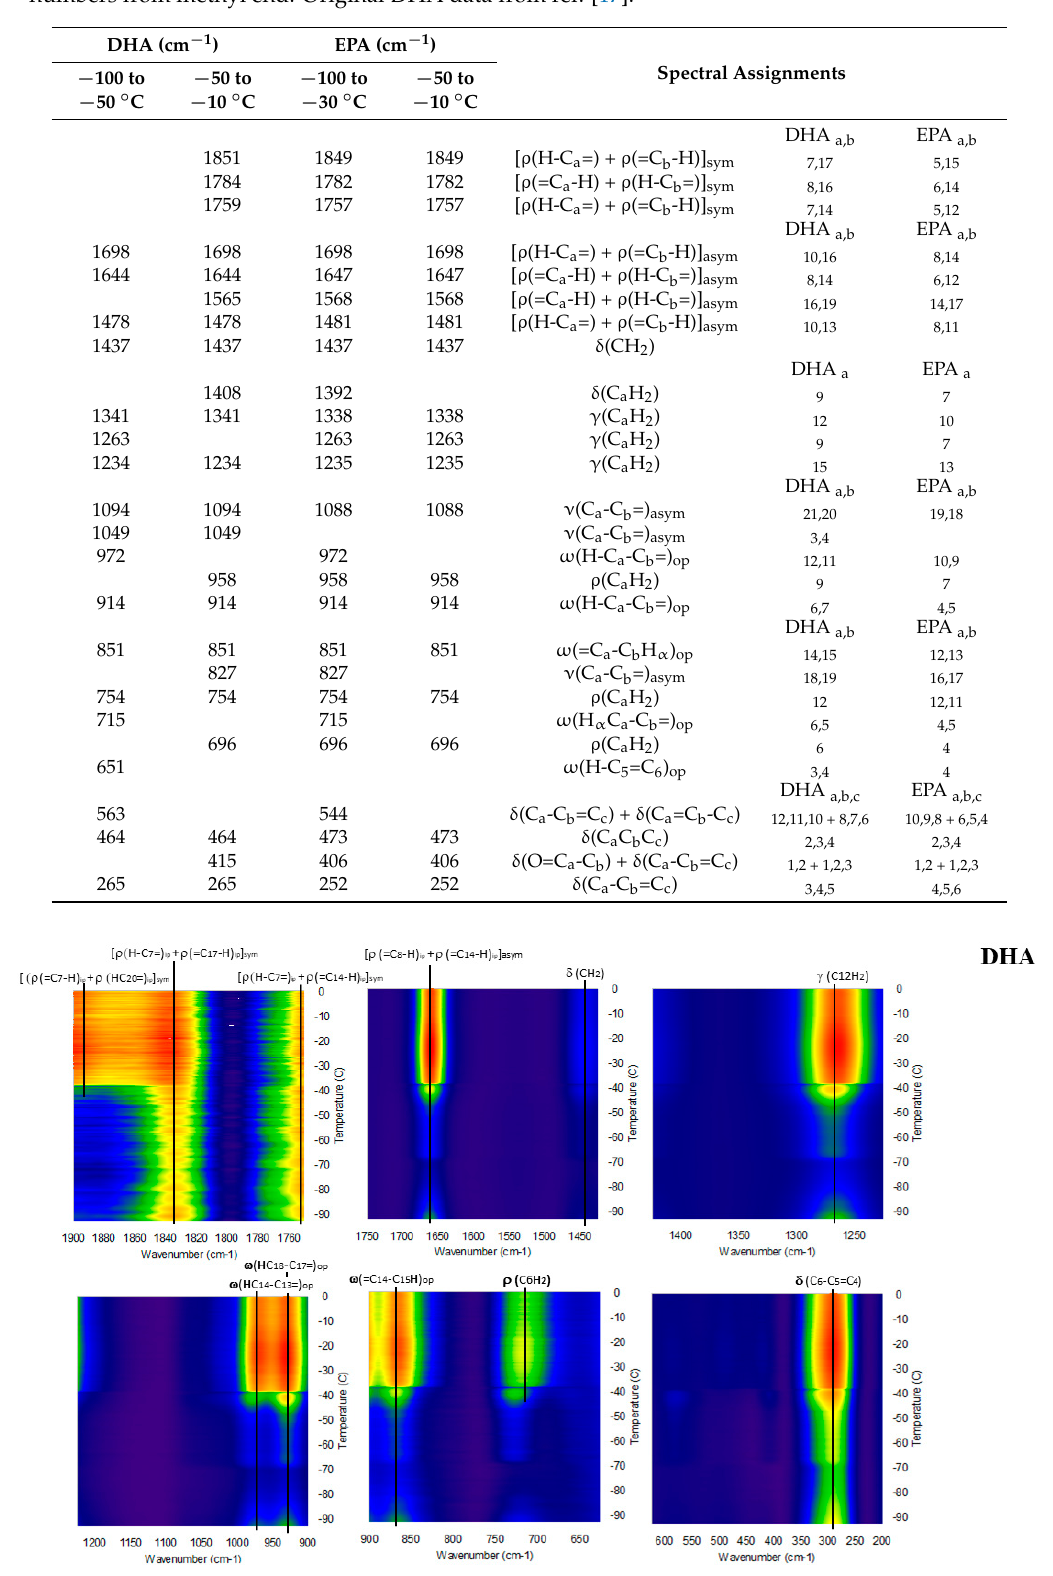
Figure 3. DHA GTRS contour plot with vibrational mode assignments. Melting is complete and heat flow returns to baseline at − 40 °C [17].